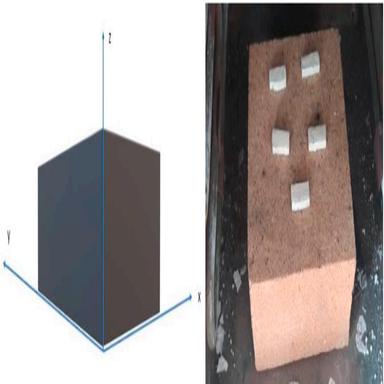
Sketch of a specimen: it has been cut considering the x-y directions of the plate (left); coated C/C samples after curing in oven for CTE measurements (right).